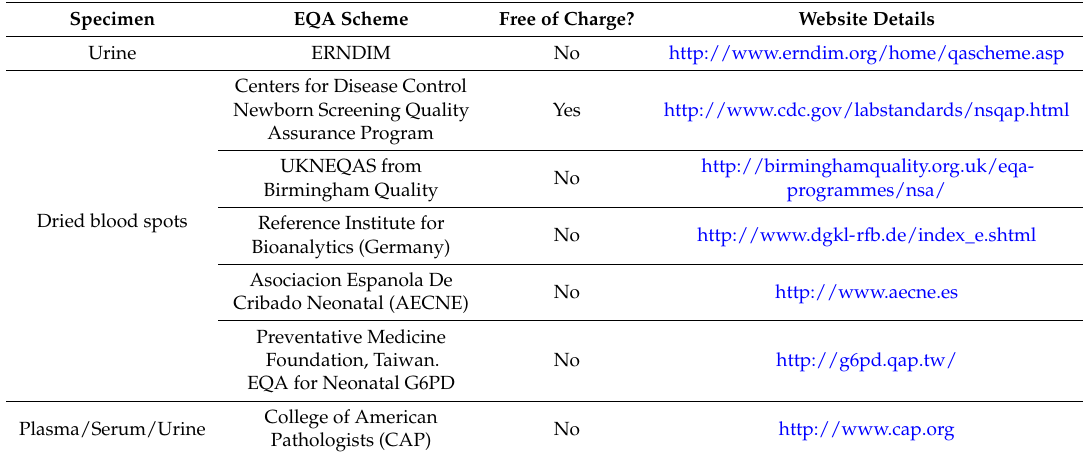
Table 2. External quality assurance